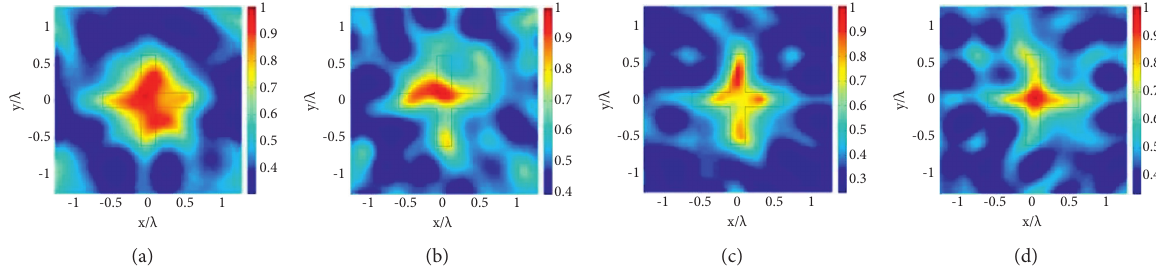
Figure 13: LSM images of the cross-shaped PEC target in xOy plane. (a) θ -Oriented dipoles, SNR � 10 dB; (b) θ -oriented dipoles,